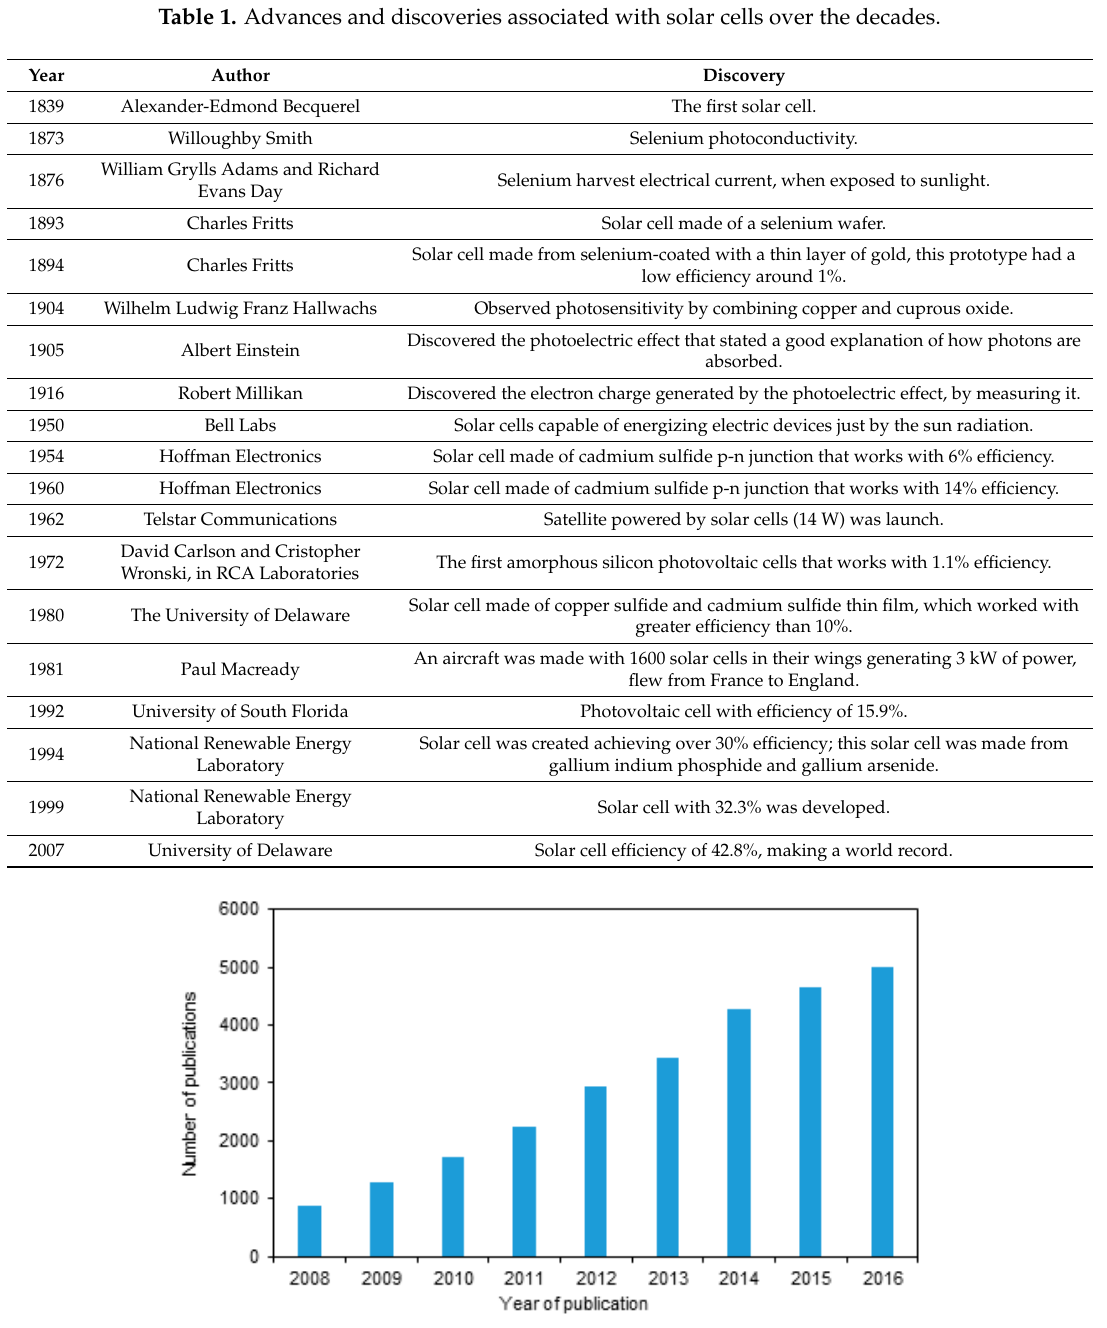
Table 1. Advances and discoveries associated with solar cells over the decades.